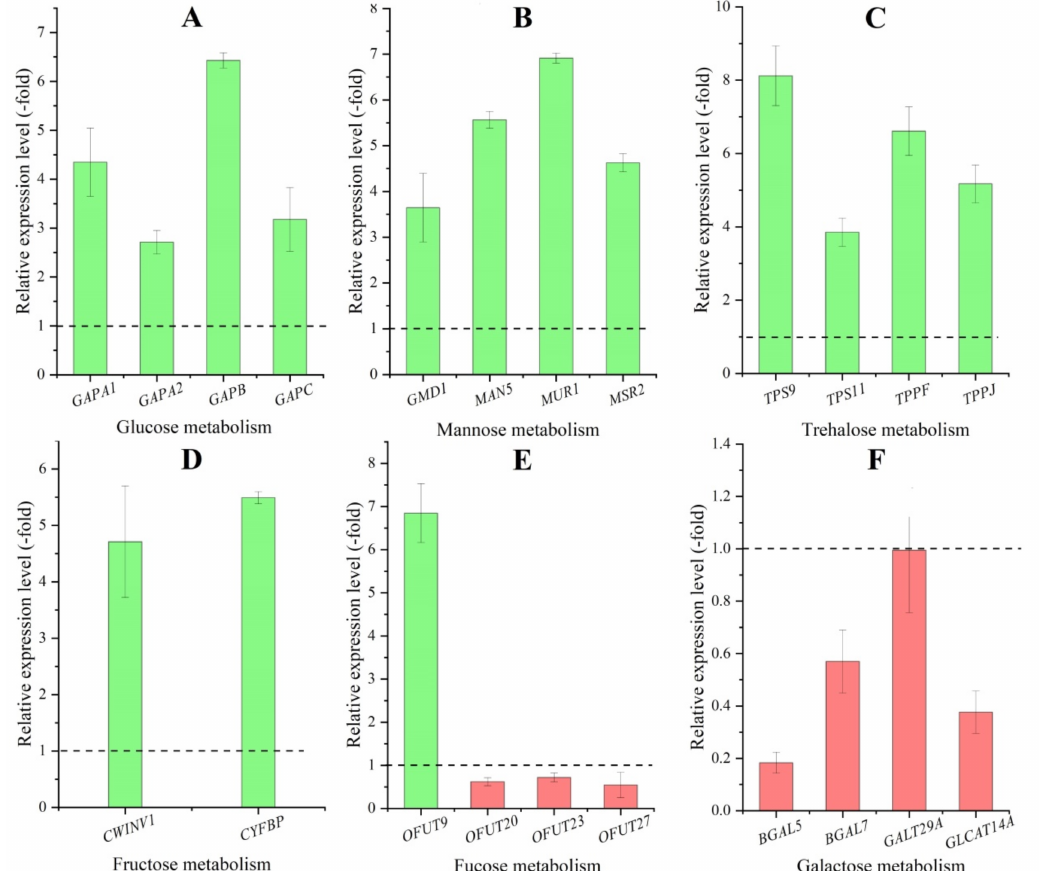
Figure 8. The relative expression level of genes involved in metabolism process of glucose ( A ), mannose ( B ), trehalose ( C ), fructose ( D ), fucose ( E ) and galactose ( F ) in the CR compared with CS, as determined by qRT-PCR. Column highlighted in green represents genes UR and red represents genes DR. The dotted line in the images differentiates UR (>1) and DR (<1) in CR compared with CS, represented. The same